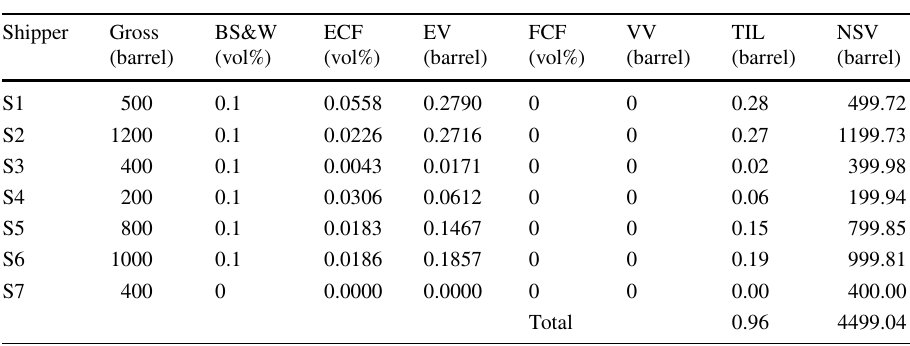
Table 11 Individual losses